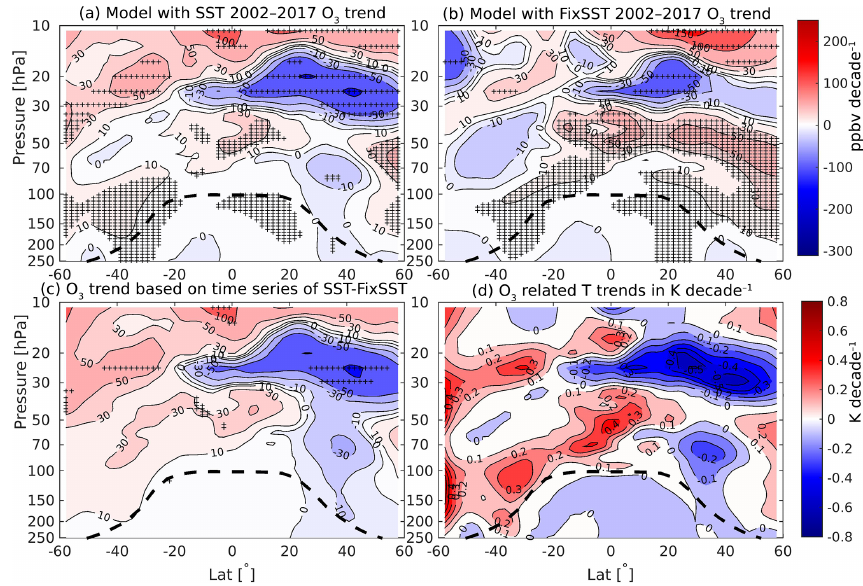
Figure 16. Ozone trend in ppbv per decade based on model simulations with time-varying SST (a) , fixed SST (b) and their differences, SST–fixed SST (c) , for the period 2002–2017. (d) Model ozone-related GNSS RO temperature trends in K per decade. The “ + ” marks trends found to be more than 95% statistically significant. The dashed black lines mark the tropopause height calculated with GNSS RO